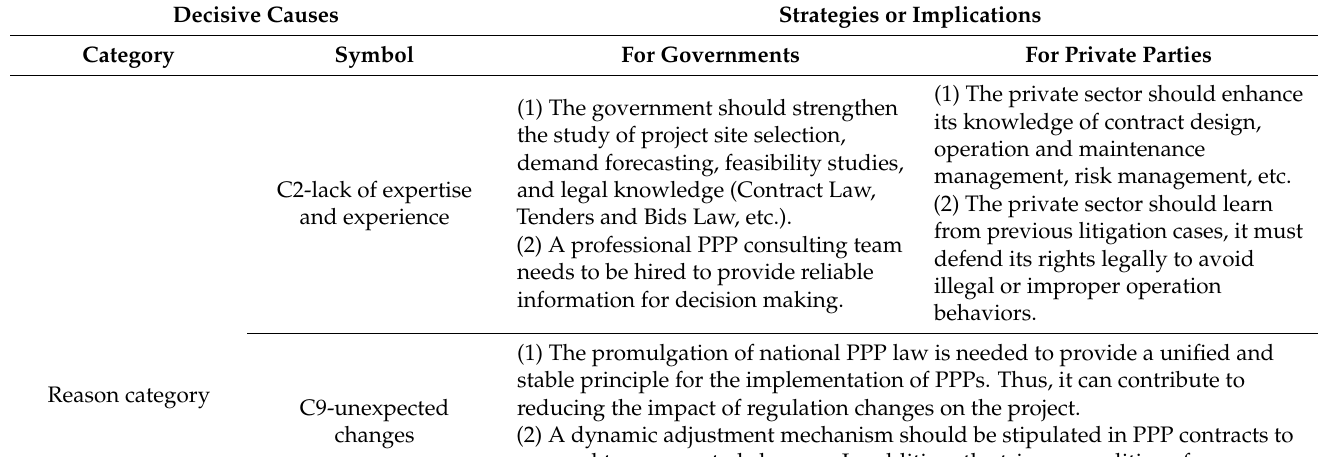
Table 8. The results and